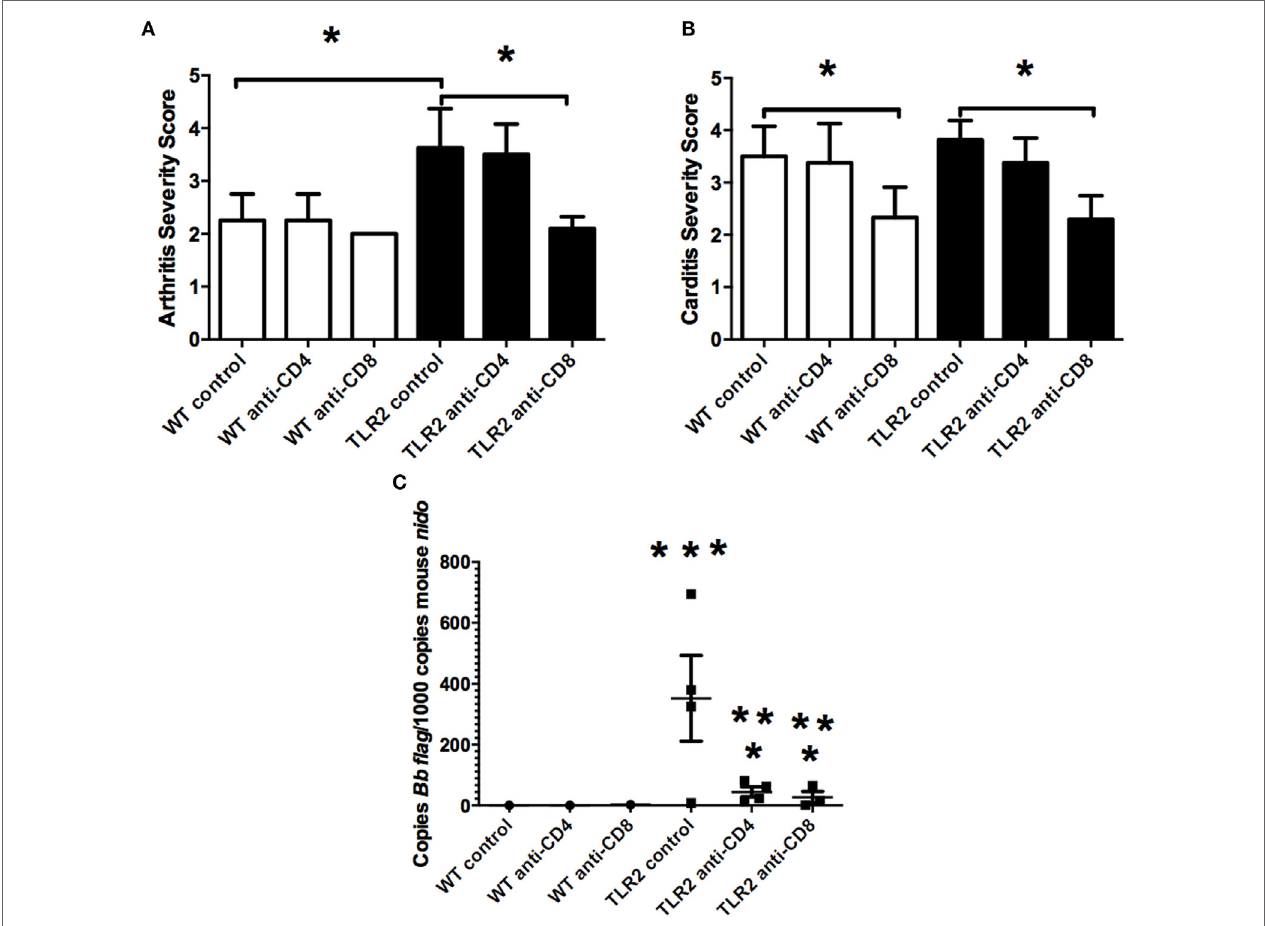
FigUre 5 | arthritis and carditis severity scores . Mice were infected and treated as in Figure 4 . On day 21 postinfection, the mice were sacrificed and ankles (a) and hearts (B) were processed for histology and scored for lesion severity. Levels of B. burgdorferi in tissue were determined by qRT-PCR (c) . Data are representative of two separate experiments. n = 8, bars represent means ± SD. * vs. TLR2 − / − control, ** vs. WT CD4 or CD8-depleted mice, *** vs. WT control, p >